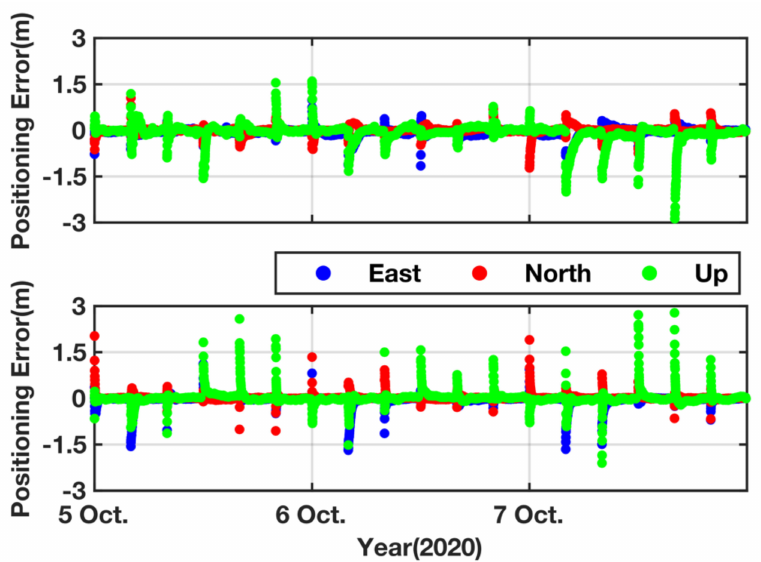
Figure 15. Kinematic PPP positioning errors at the SHA1 station (top panel for PPP-B2b and bottom panel for GBM).